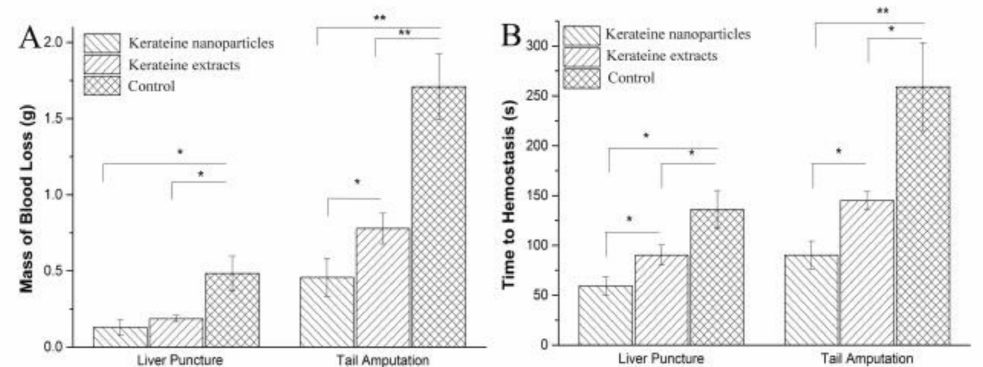
Figure 6. ( A ) Mass of blood loss and ( B ) time to hemostasis in rat liver puncture and tail amputation models treated with keratin extracts and KNPs (** p < 0.01 and * p < 0.05 compared with the control group, n = 3). Reprinted with permission from